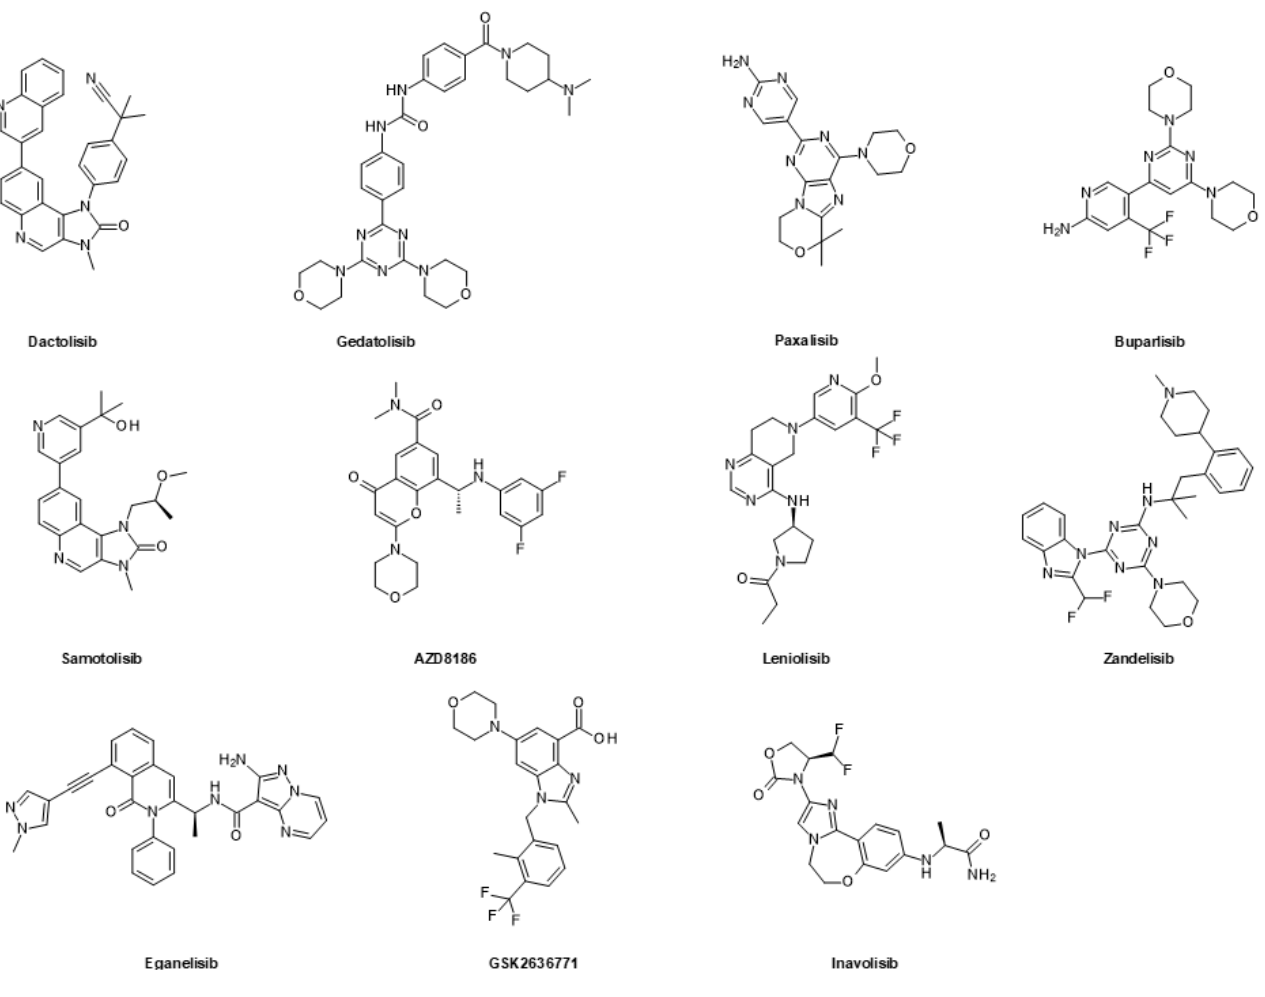
Figure 6. Inhibitors of PI3K in advanced clinical trials.